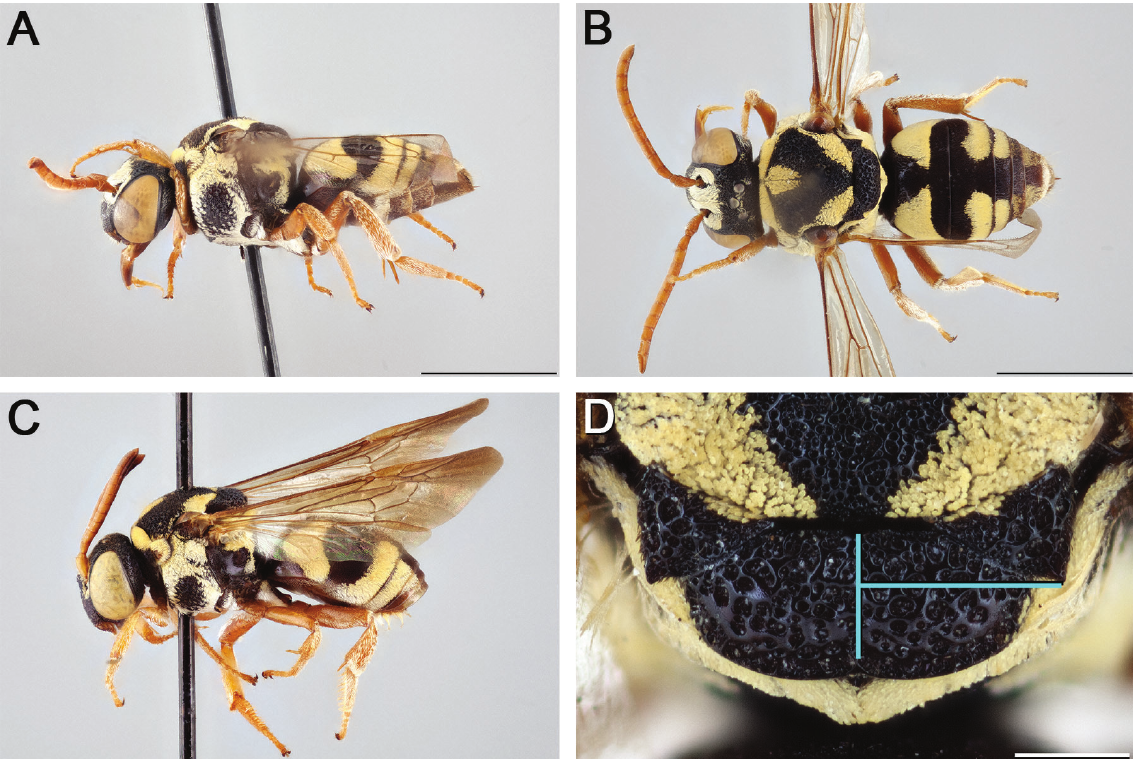
Fig. 19. Epeolus pulchellus Cresson, 1865 A . Female, habitus, lateral view. B . Female, habitus, dorsal view. C . Male, habitus, lateral view. D . Female axillae and mesoscutellum, dorsal view (blue lines indicate the posterior extent of the axilla relative to the length of the horizontal dorsal portion of the mesoscutellum). Scale bars: A–C = 3 mm; D = 0.5